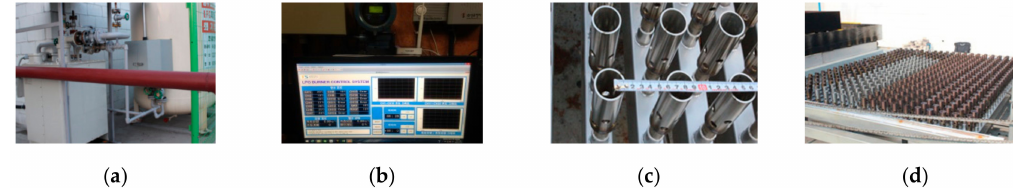
Figure 13. Components of final test apparatus: ( a ) LPG storage tank & vaporizer; ( b ) LPG flow rate control system; ( c ) burners with spacing 75 mm (center to center); ( d ) burner zone with 625 nozzles in five modules.